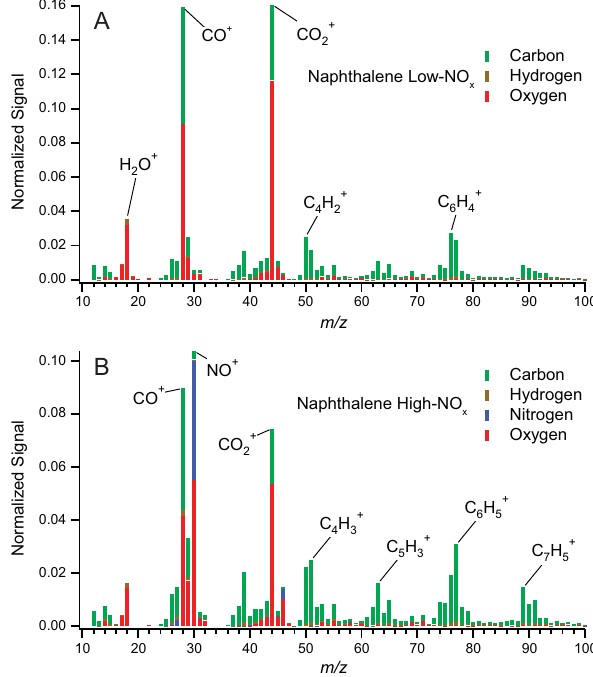
Fig. 14. High-resolution mass spectra of naphthalene-SOA formed under low-NO x (A) and high-NO x (B) conditions with elemental contributions to each mass-to-charge ratio shown. Spectra were taken at the peak of SOA